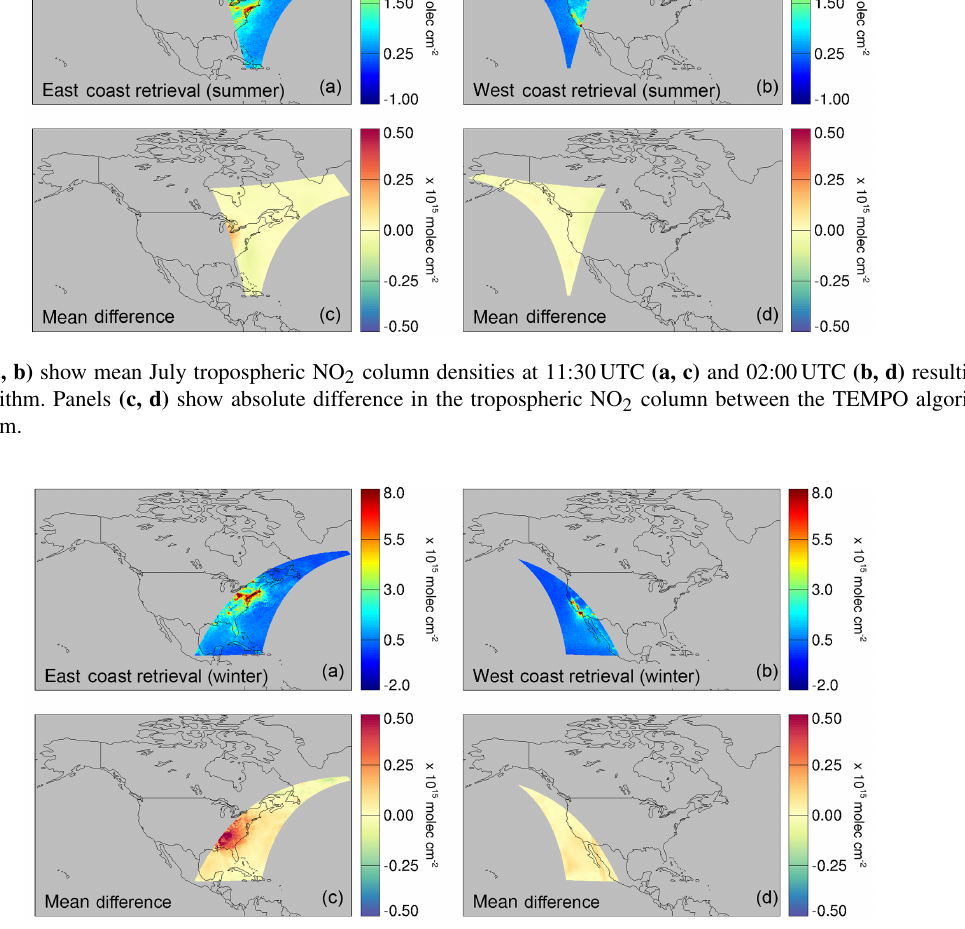
Figure 10. Panels (a, b) show mean January tropospheric NO 2 column densities at 14:00UTC (a, c) and 23:30UTC (b, d) resulting from our TEMPO STS algorithm. (c, d) show absolute difference in the tropospheric NO 2 column between the TEMPO algorithm and the global STS